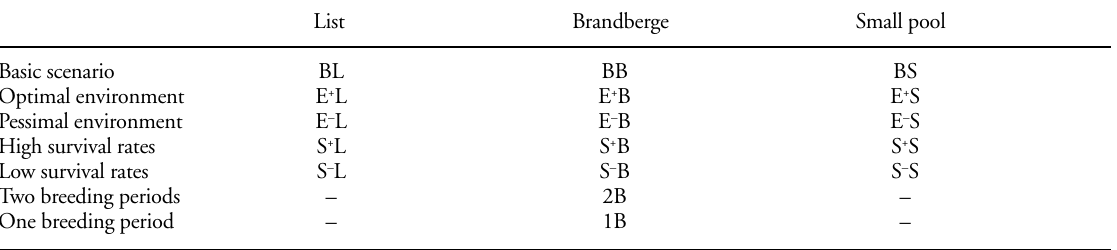
Table 2. Scenario overview for the stochastic simulation model. Different environmental conditions and different survival rates were investigated for all three basic scenarios, variations in the number of breeding periods were limited to the Brandberge scenario.